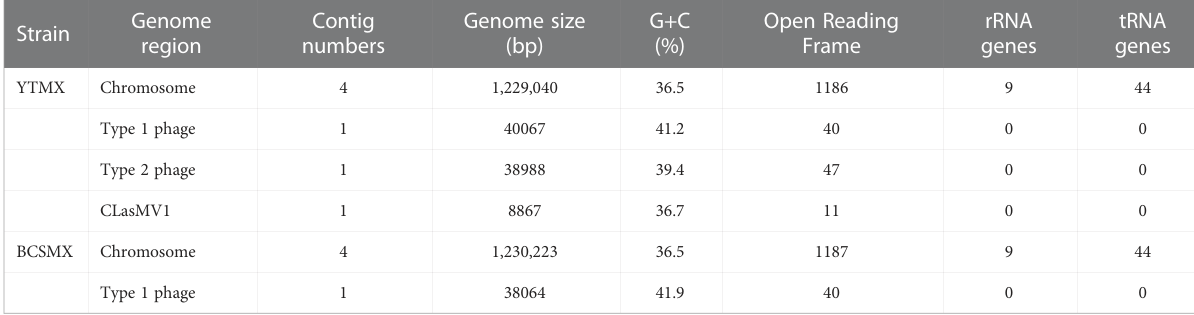
TABLE 3 Selected metrics of two whole genome sequences of “ Candidatus Liberibacter asiaticus ” strains from